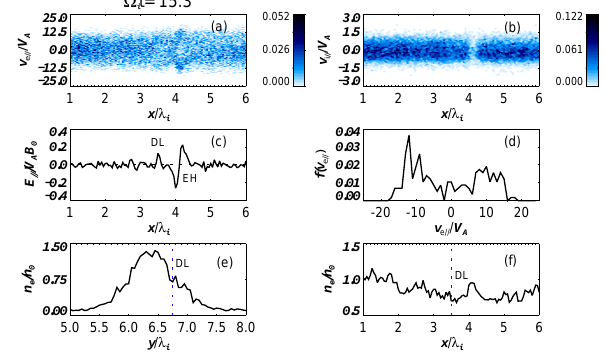
Figure 2. The v // − x phase-space distributions of electron (a) and ion (b) , and the electric field E // at y/λ i = 6 . 75 (c) , the parallel velocity distribution of electron f (v e // ) at about x/λ i = 4 . 1 and y/λ i = 6 . 75 (d) , the density distribution of electron along y axis at y/λ i = 3 . 5 where the double layer (DL) appear (e) and the density distribution of electron along x axis at y/λ i = 6 . 75 (f)